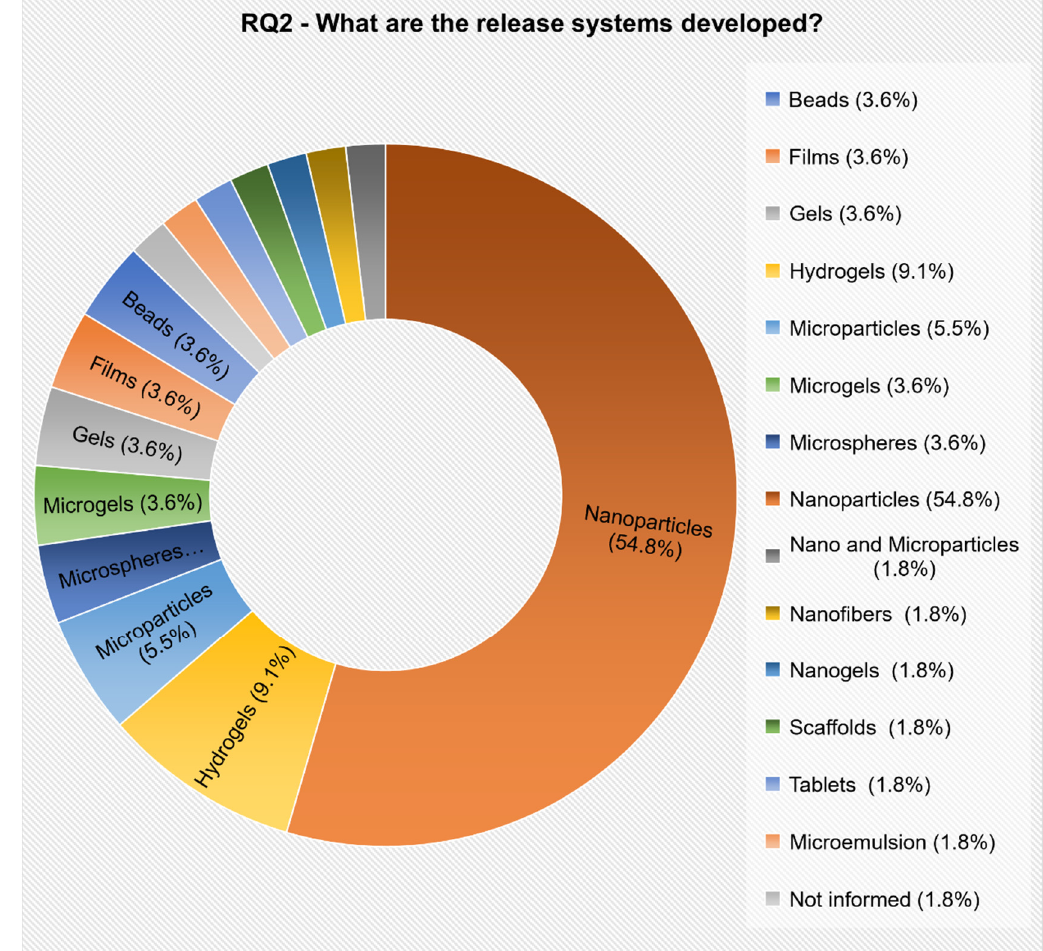
Figure 9. Release system models presented in the selected articles, according to RQ2.